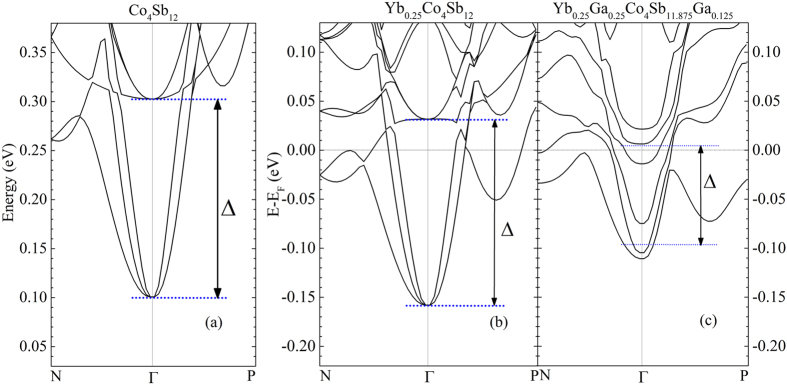
Theoretical calculation of electronic band structures.First-principles band structure calculations for (a) Co4Sb12, (b) Yb0.25Co4Sb12, and (c) Yb0.25Ga0.25Co4Sb11.875Ga0.125. The zero energy points in (b,c) represent the Fermi levels (EFs) of the two compounds.